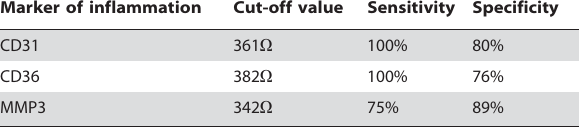
Table 1. Value of electric impedance measurements in detecting inflammatory processes defined by different markers of